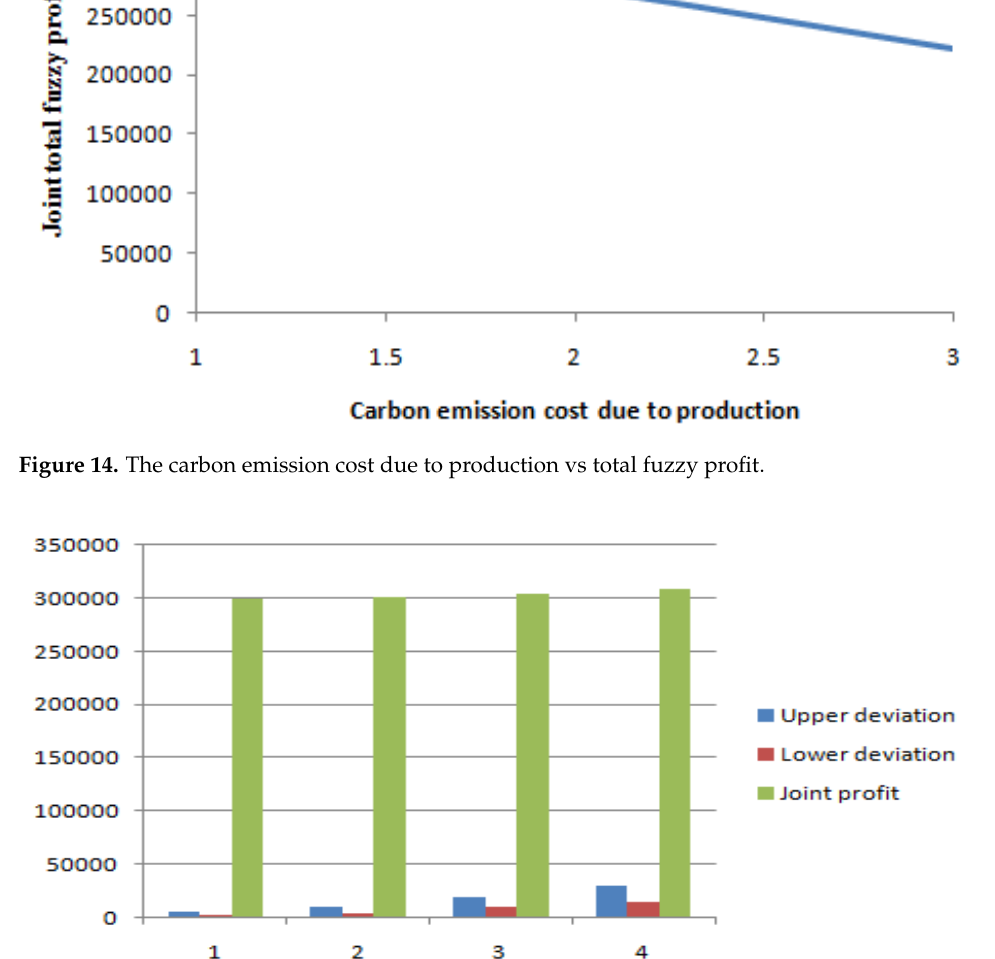
Figure 15. Upper and lower deviation of the demand rate vs. the joint total fuzzy profit.